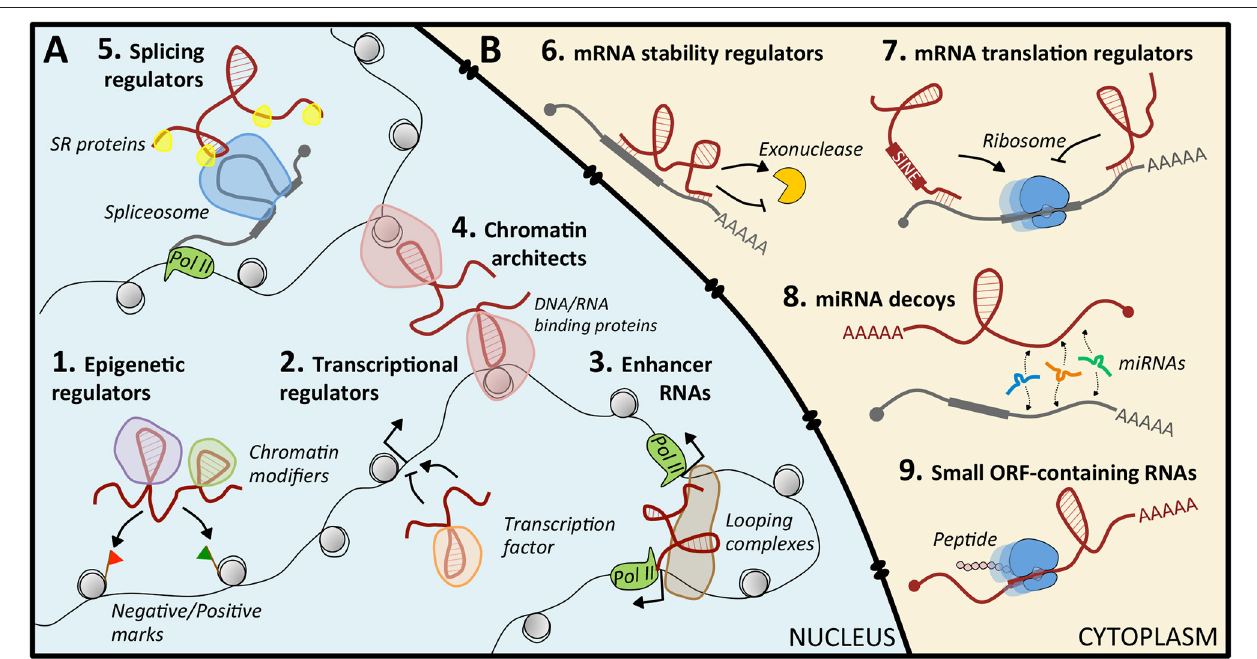
FIGURE 1 | Mechanisms of action of lncRNAs. (A) In the nucleus, lncRNAs can regulate gene expression by guiding epigenetic (1) or transcription (2) factors to specific loci, by acting as enhancers (3), by structuring the three-dimensional conformation of chromatin (4), or by recruiting splicing factors (5). (B) In the cytoplasm, they act by modulating mRNA stability (6) or translation (7), by sequestering miRNAs (8), or by coding small peptides